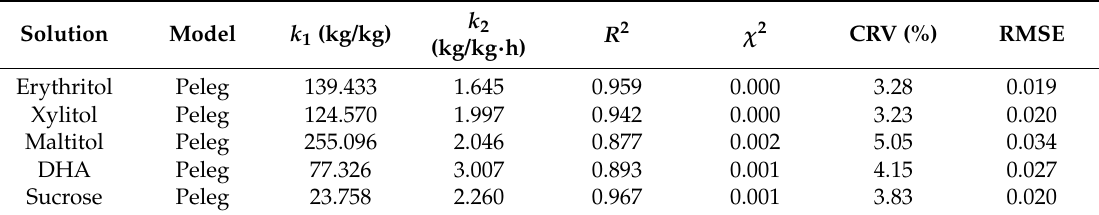
Table 9. The values of k 1 , k 2 , R 2 , χ 2 , CRV and RMSE of modeling Cichowska’s et al. ratio (CR) using Peleg’s model.